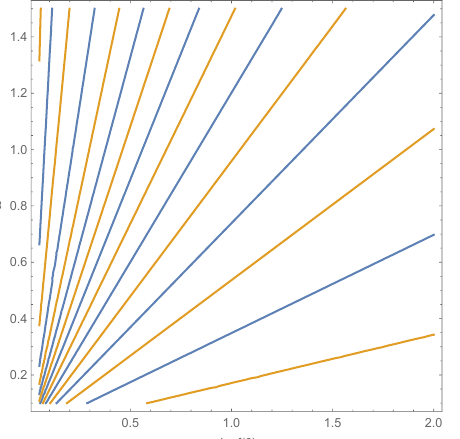
Figure 4 . A two-dimensional plot of the zeroes of the real and imaginary parts of G ( !; Im f (0)), which highlights the degeneracy associated with the scaling invariance of the parabolic case. It is not possible to identify solution rays from this type of diagram.